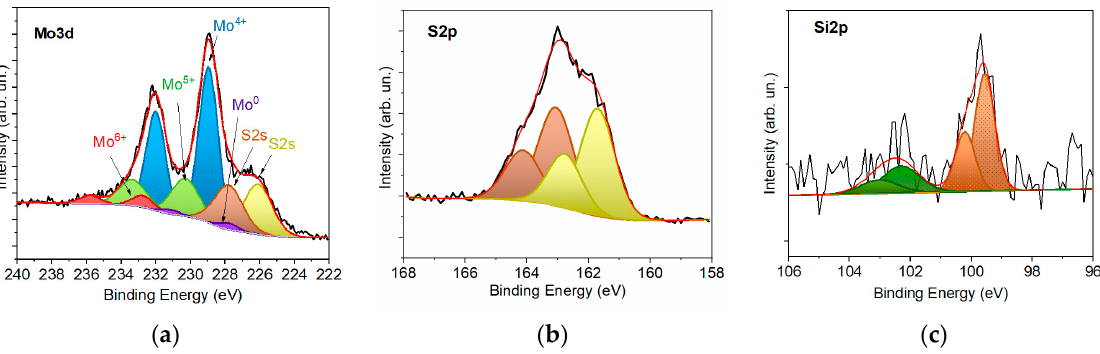
Figure 5. XPS ( a ) Mo3d, ( b ) S2p, and ( c ) Si2p spectra measured for a 4 nm thick a-MoS x /NP-Mo